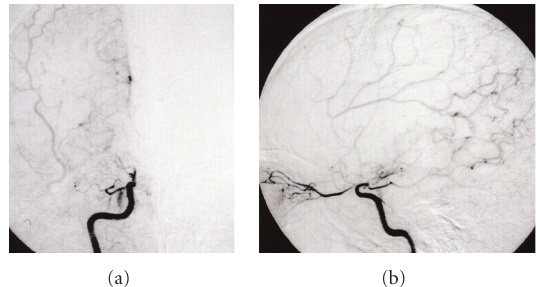
Figure 3: Right internal carotid artery angiogram. Angiogram reveals occlusion of the right internal carotid artery C1 segment. Note the collateral cerebral blood flow arising from posterior